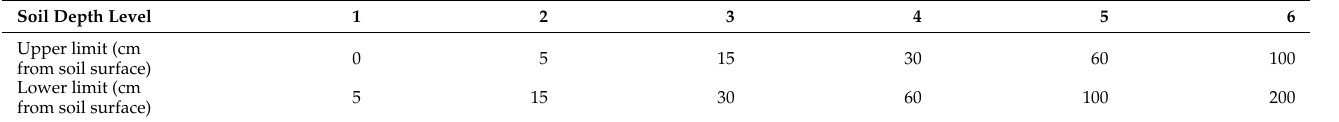
Table 1. Soil depth levels in